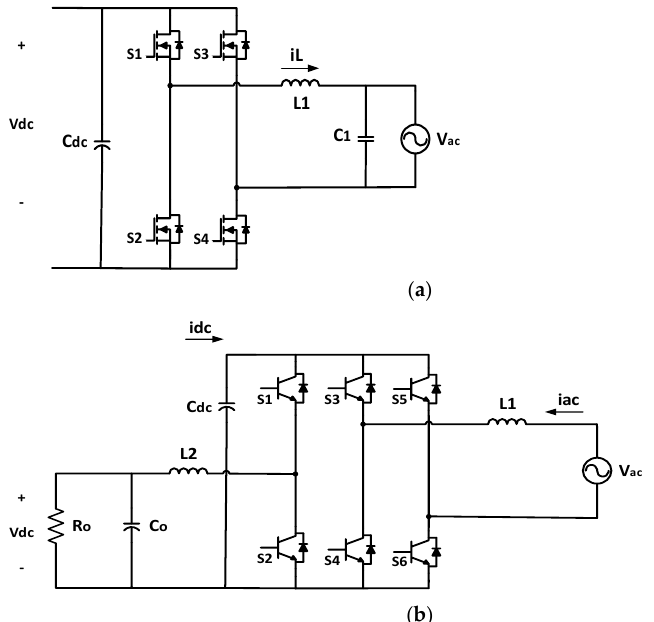
Figure 6. Bidirectional inverter ( a ) conventional H4 [52] and ( b ) two-stage topology [64].